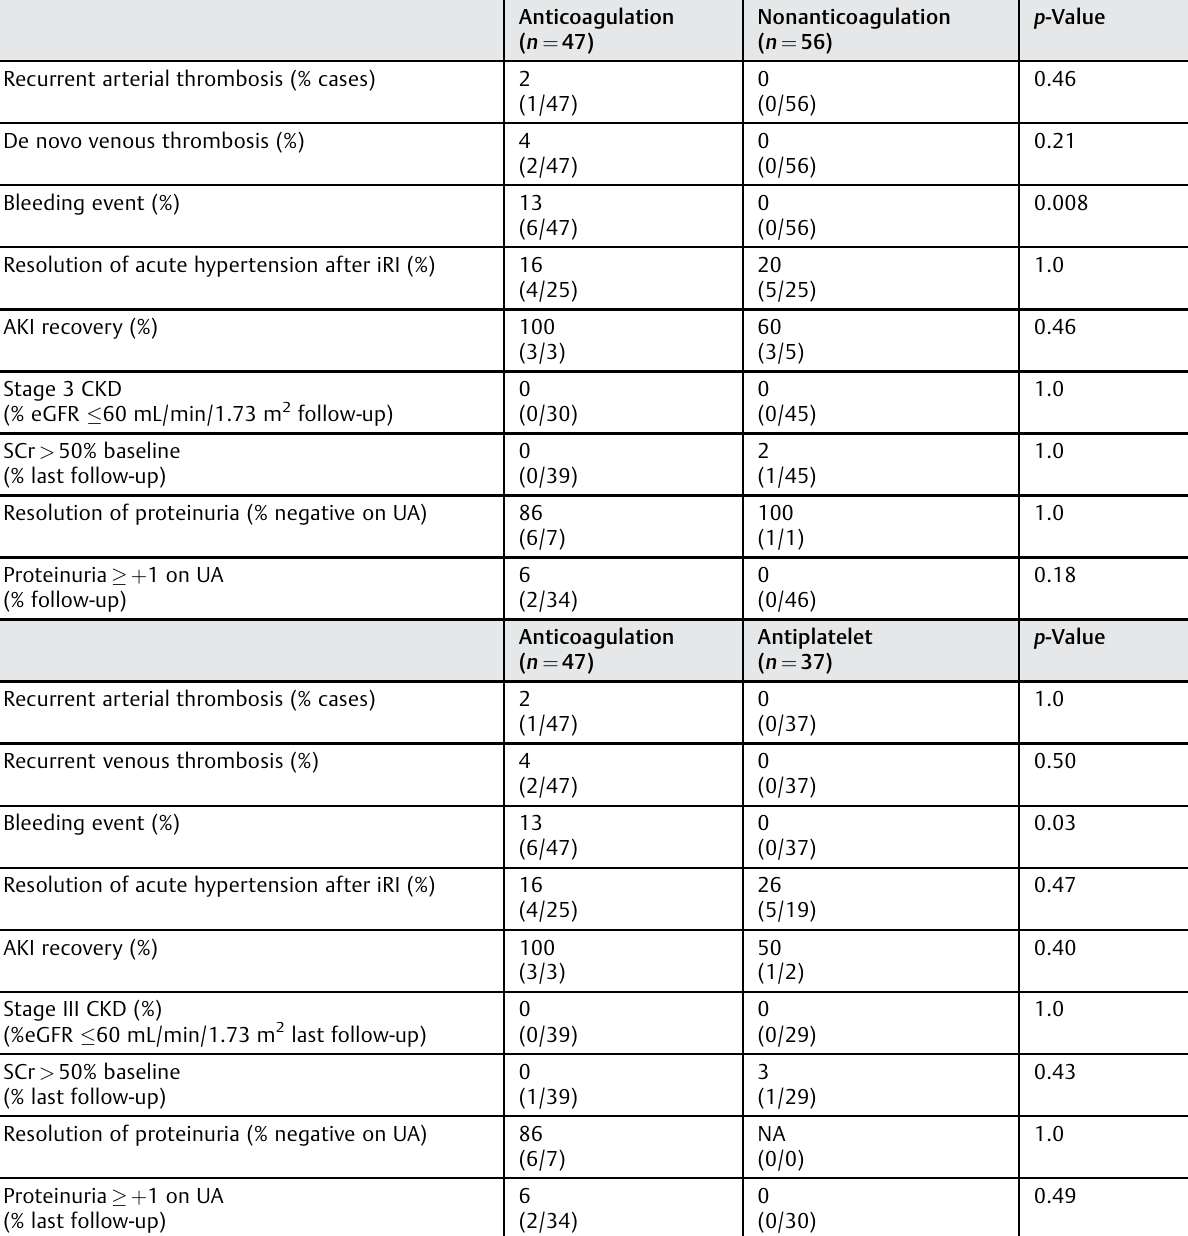
Table 2 A comparison of long-term outcomes after idiopathic renal infarction between anticoagulation and nonanticoagulation groups ( top ) and between anticoagulation and antiplatelet groups ( bottom